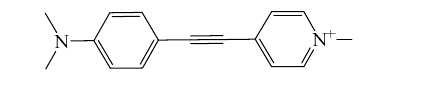
Figure 14. Molecular structure of ionic salt with tolan structure.